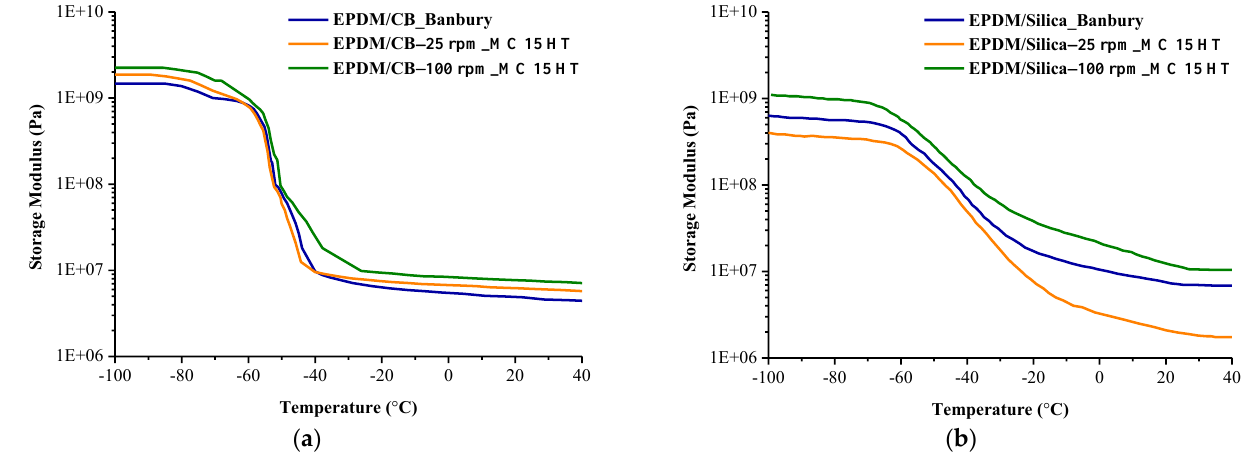
Figure 12. The storage modulus of ( a ) EPDM/CB ( b ) EPDM/Silica composites prepared in Banbury and MC 15 HT.